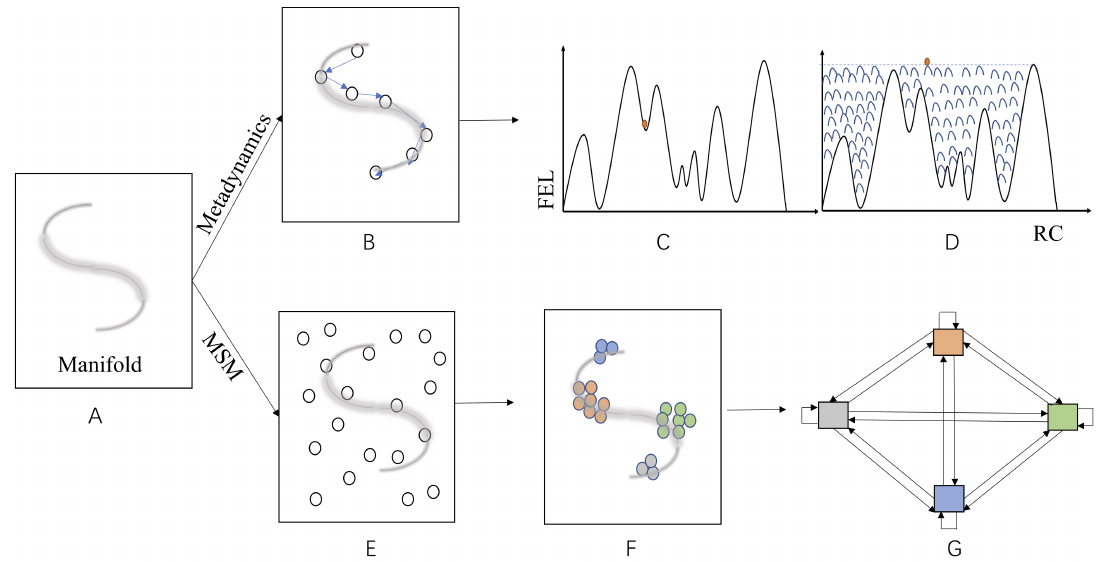
Figure 3. Schematic illustration of essential features for enhanced sampling by metadynamics and MSM. ( A ) The “S” shape grey line represents the unknown manifold in the configurational space (represented by the square) of a molecular system. ( B ) Small circles connected by blue arrows represent computed (guessed) RC/CVs for the molecular system, which is utilized to conduct metadynamics simulations. ( C ) The FEL of the molecular system along the computed/selected RC/CV in ( B , D ) “Caching” of the LFEL by bias potentials (gaussians represented by blue bell shaped lines) accumulated in the course of metadynamics simulations. ( E ) Distribution of the molecular system to the whole configurational space at the start of a MSM simulation, small circles represent initial start points for short MSM trajectories. ( F ) Sampling results of short MSM trajectories fall mainly near the manifold, distinct “states” are represented by different colors. ( G ) Establishment of transition matrix by transition counts between “states” obtained from short